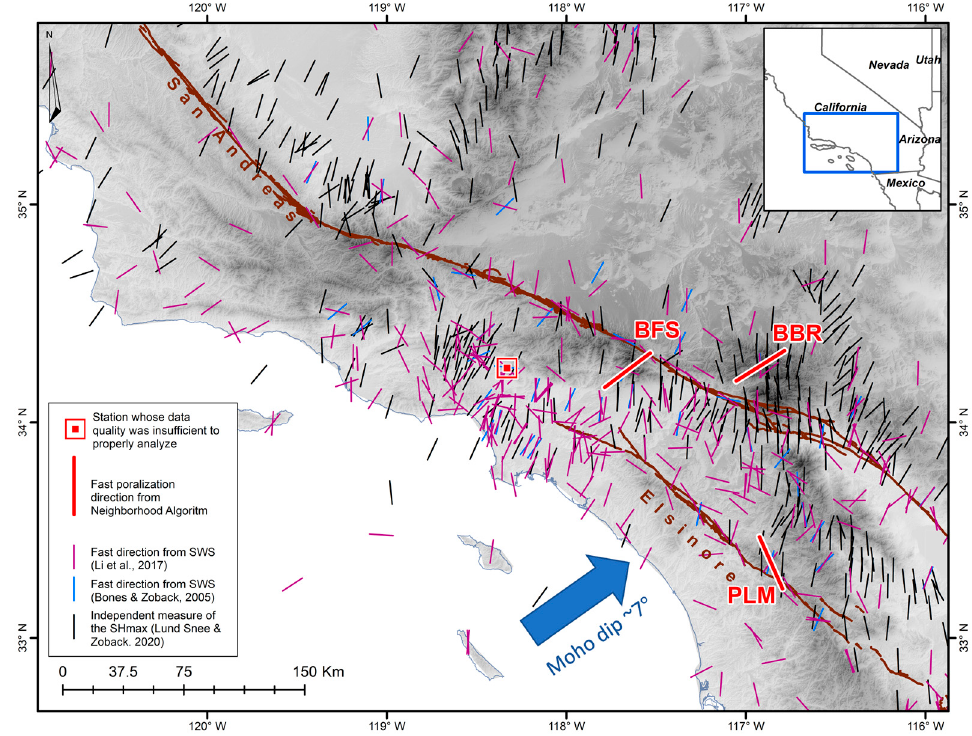
Figure 8. Map of the four permanent seismic stations in southern California with independent stress indicators [3], Moho dip direction [27,28] and dip magnitude [26] and fast polarization directions [14,15]. “SWS” signifies shear-wave splitting.